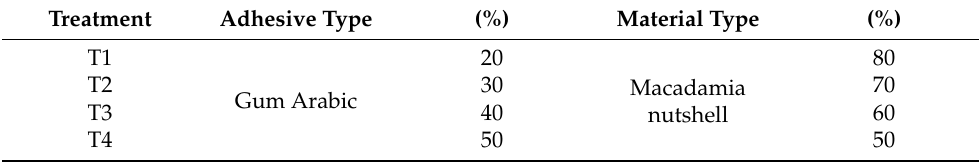
Table 2. Mix ratio for the production of gum Arabic and macadamia nutshell particleboard.